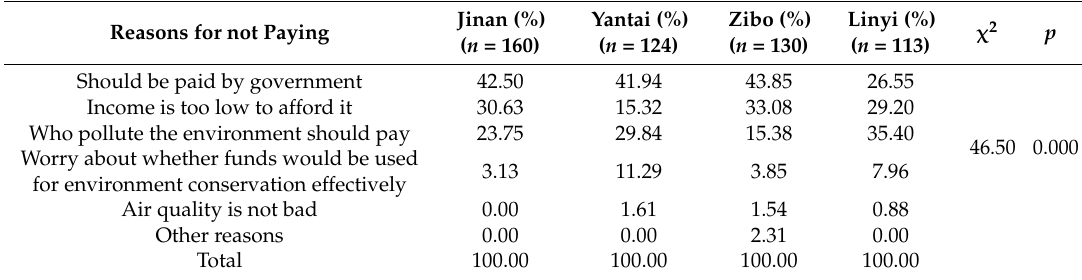
Table 7. Respondents’ reasons for not paying.